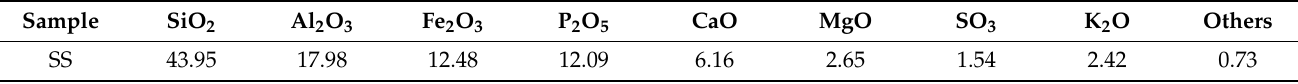
Table 2. Ash composition of sewage sludge